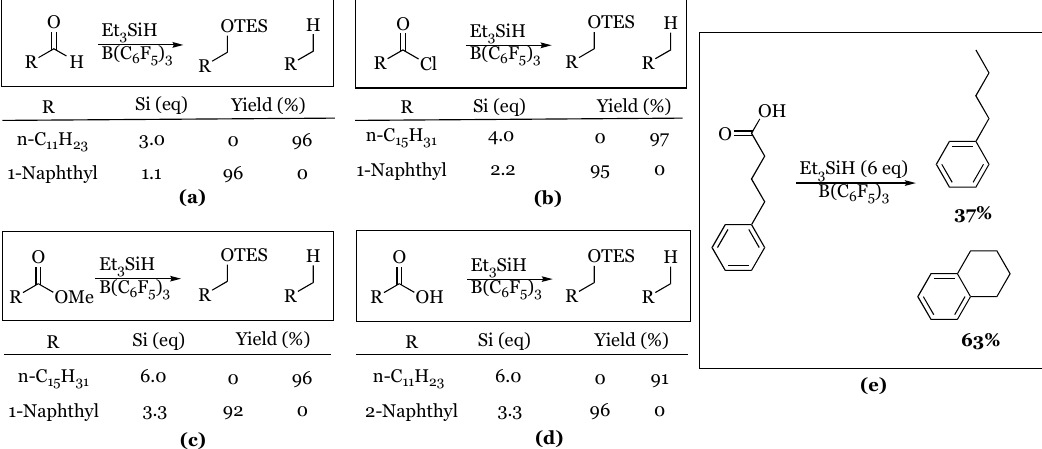
Figure 3. Representative reductions with triethylsilane: ( a ) aldehydes; ( b ) acid chlorides; ( c ) esters; ( d ) carboxylic acids; ( e ) 4-phenylbutyric acid reduction.